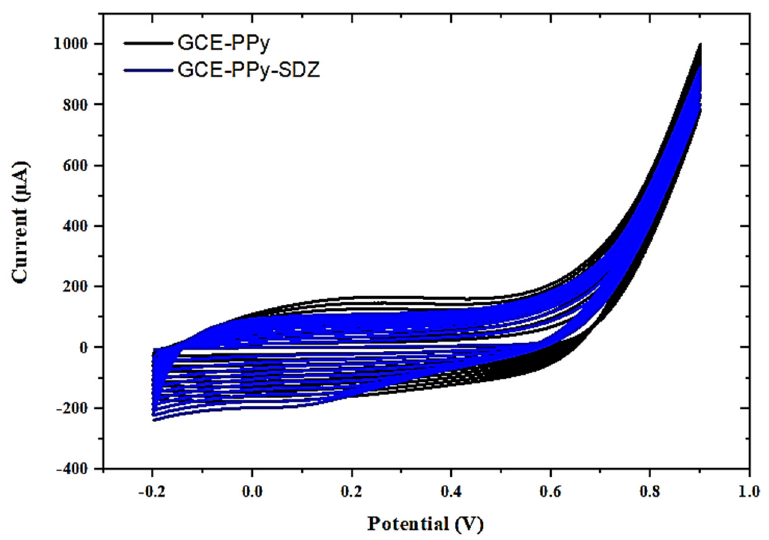
Figure 1. Cyclic voltammograms of the electro-polymerization of pyrrole (0.1 M) in the absence (black) and presence (blue) of (10 − 3 M) SDZ on GCE in 0.1 M H 2 SO 4 solution, with a scan rate of 100 mV/s and 15